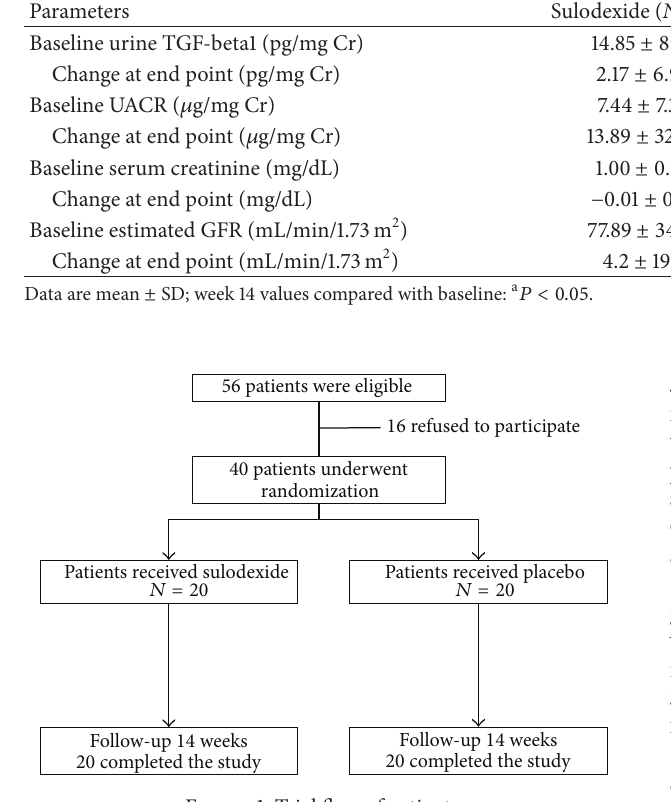
Figure 1: Trial flow of